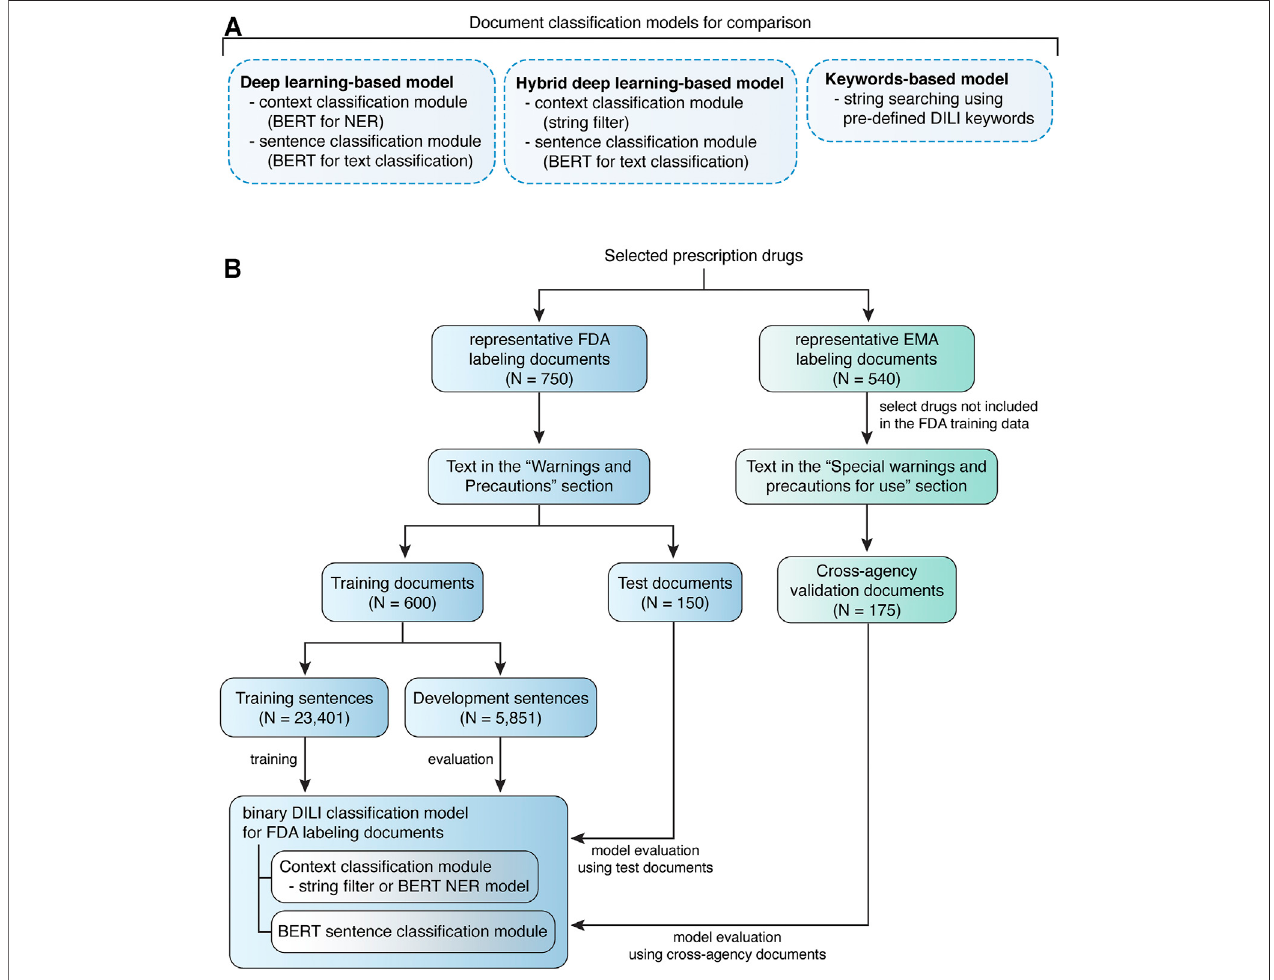
FIGURE1| Quorum fl owchartdescribes thestudy design. (A) Druglabelingdocument classi fi cation models developed and compared inthis study. (B) The study design of model training and evaluation using FDA labeling documents and model validation using EMA labeling